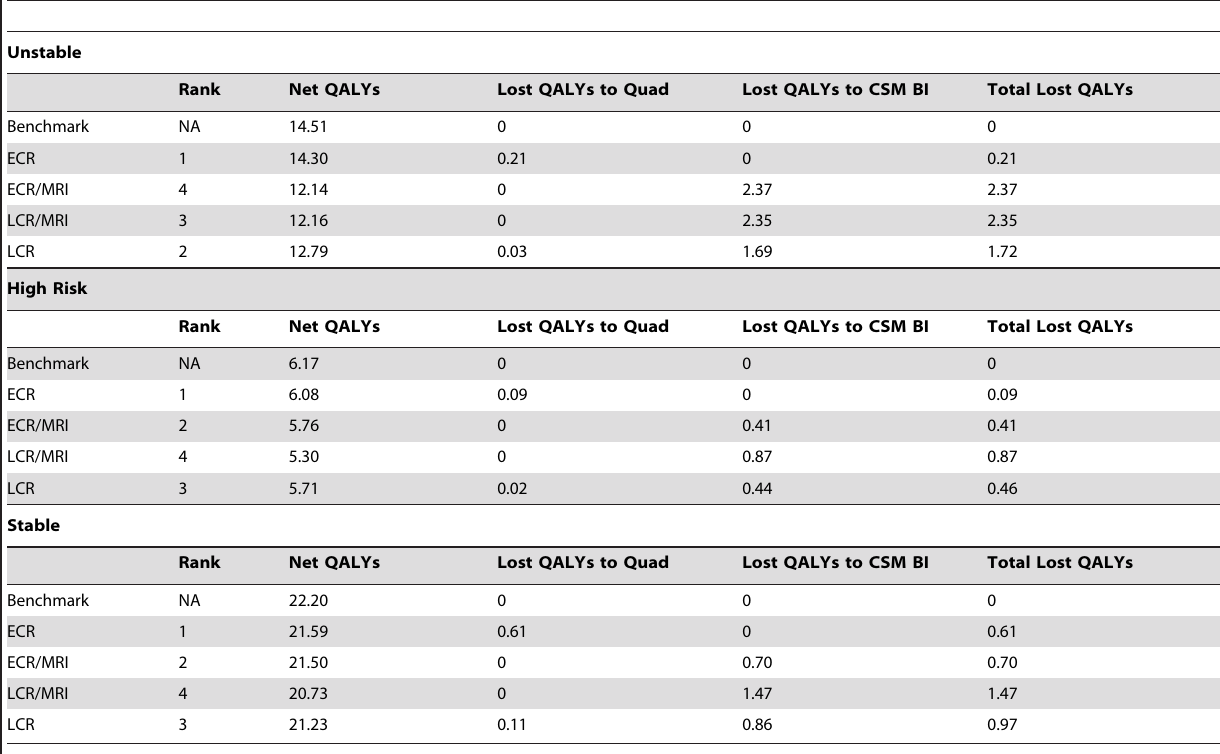
Table 4. QALYs Resulting from Quadriplegia and CS Management Complications with a 2.5% Probability of Cervical Spine Instability in the categories of TBI.